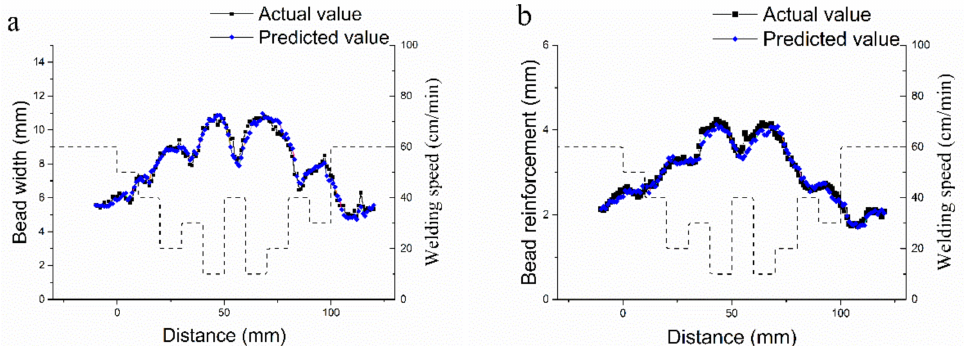
Figure 8. Comparison of predicted and actual results in test dataset: ( a ): bead width value; and, ( b ): bead reinforcement